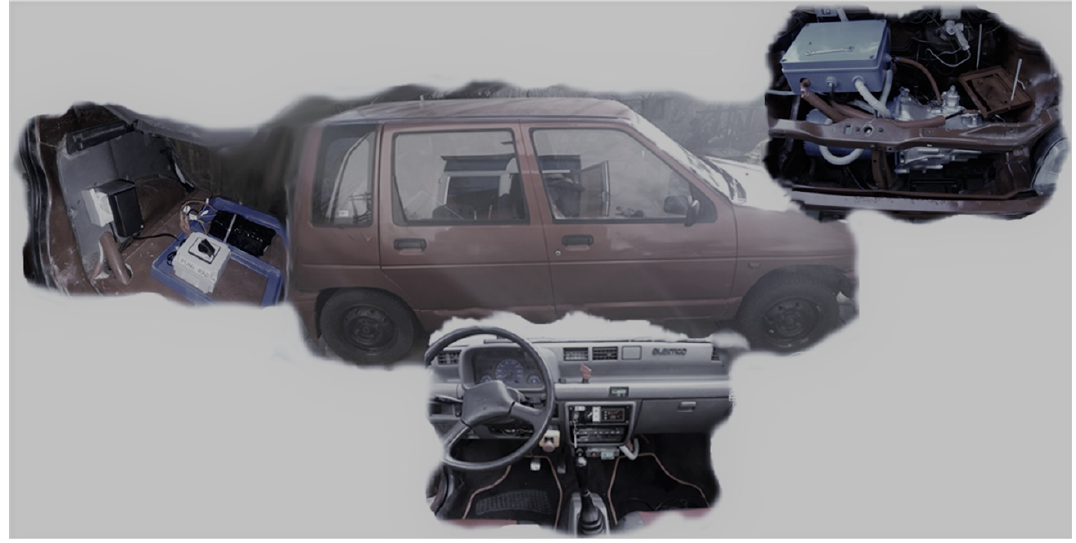
Figure 1. Laboratory production of EV Daewoo Tico with the AGM battery pack.